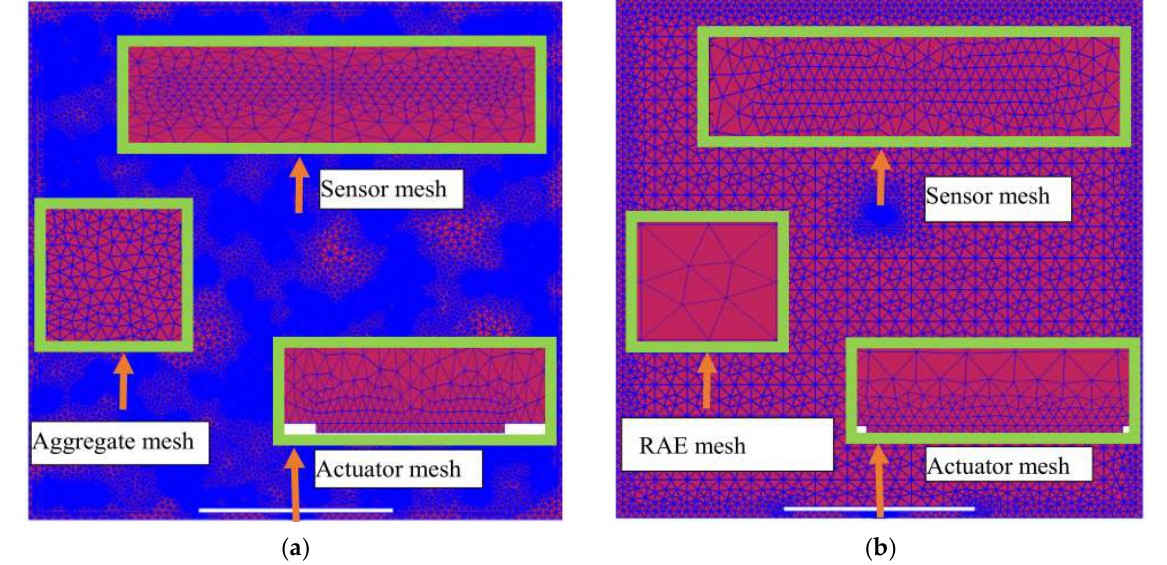
Figure 3. Meshing of the mesoscale RCFST–PZT coupling model and its corresponding homogenization model when the frequency of excitation is 40 kHz. ( a ) CMFEM 1; ( b ) CHFEM with RAE dimension of 25 mm by 25 mm.